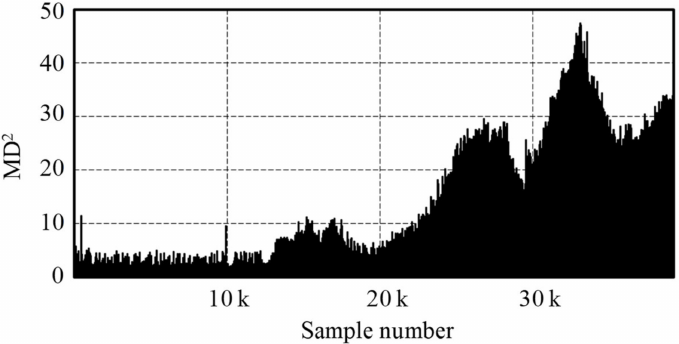
Figure 7. MD 2 values using constant percentage bandwidth in the 1 / 3 octave